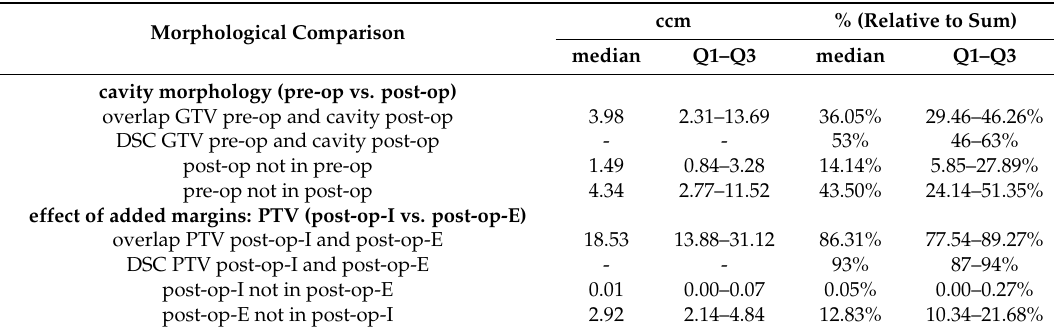
Table 3. Morphological comparison of target volumes and margins, including similarity, areas of overlap and difference. Absolute volumes are listed to the left; to the right are listed volumes relative to the combined sum of the two respective